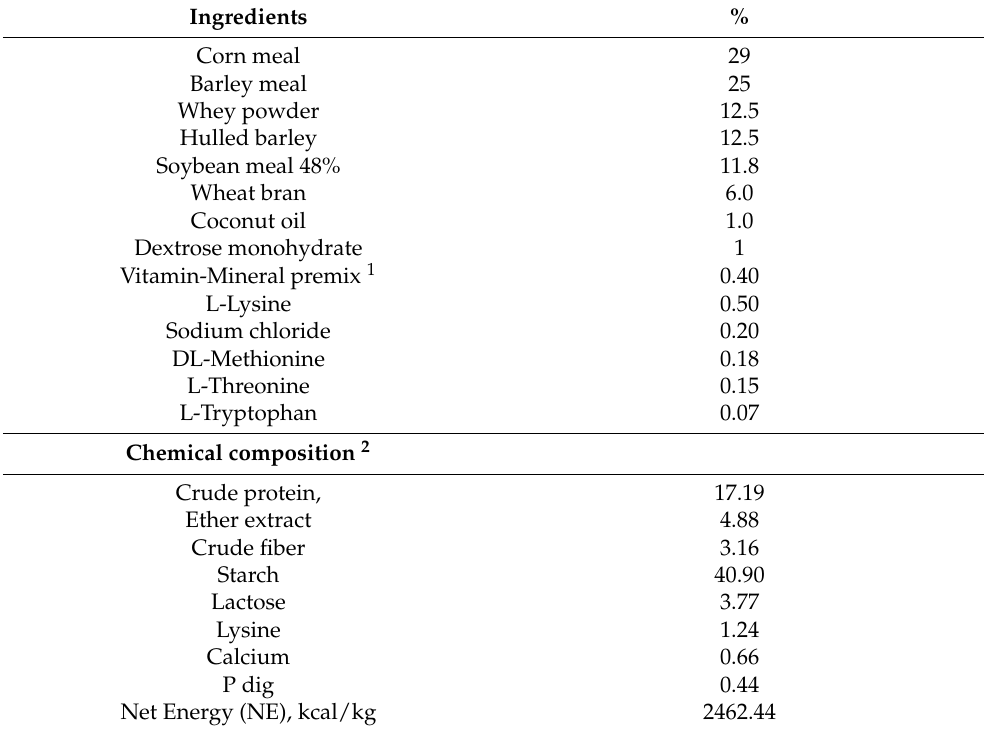
Table 1. Ingredients (%) and proximate chemical composition of the basal diet (as-fed basis).